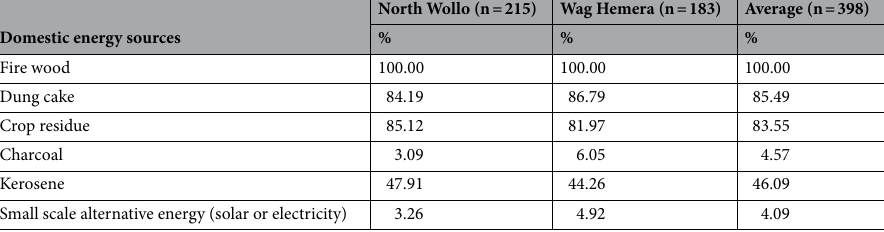
Table 1. Domestic energy sources in northern highlands of